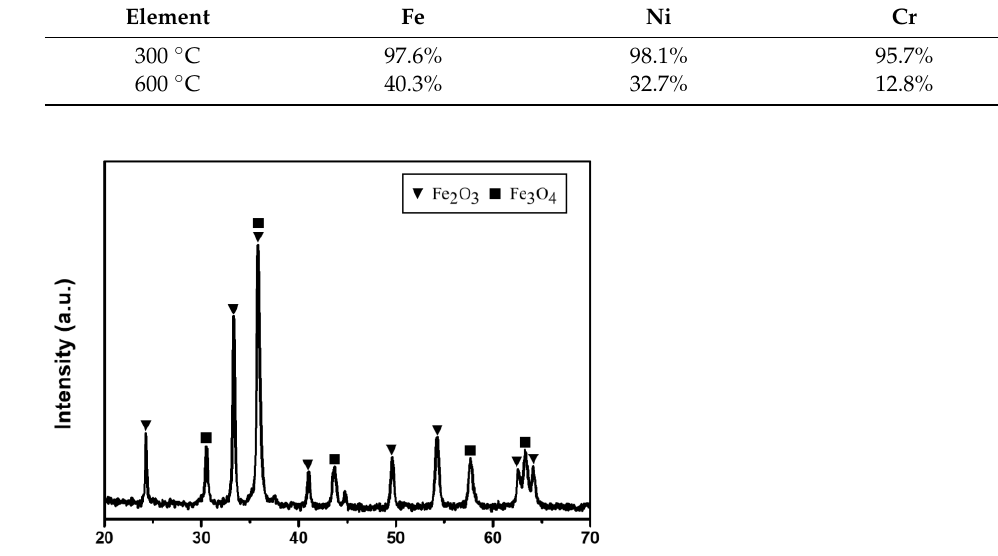
Figure 4. The X-ray diffraction (XRD) pattern of stainless steel sludge calcined at 600 °C.